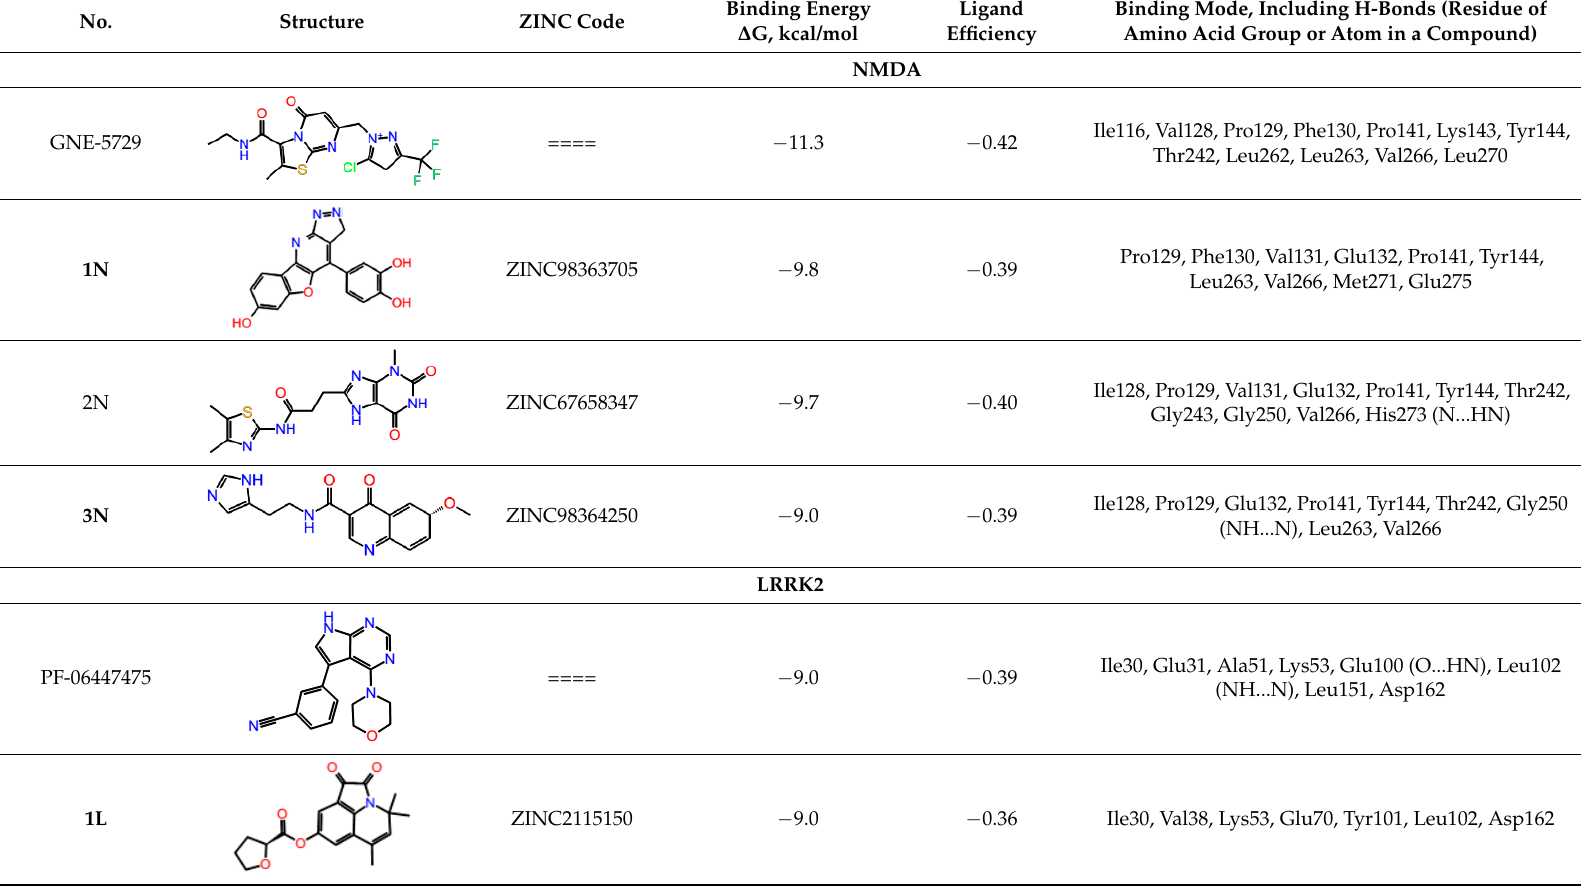
Figure 2. Linear fit between experimental and observed logIC 50 of the BMLR models: ( A ) LRRK2 set; ( B ) NMDA set; ( C ) TrkA set. Trend lines indicated by straight lines. BMLR equations in Table 2 are also incorporated in the boxes. Table 3. Binding energies (kcal/mol) and binding modes of small-molecule ligands to receptors (LRRK2, NMDA, and TrkA).